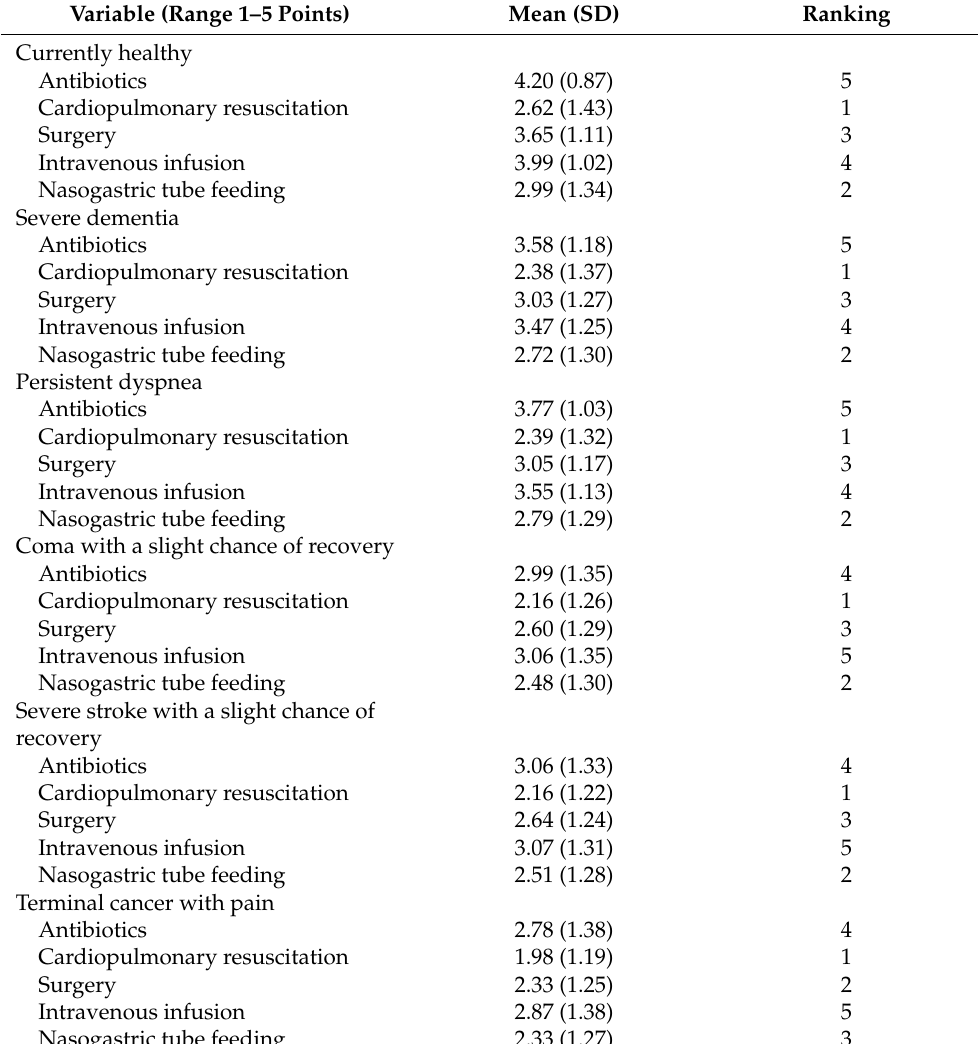
Table 2. Older adults’ preferences about end-of-life treatments (N = 342). Variable (Range 1–5